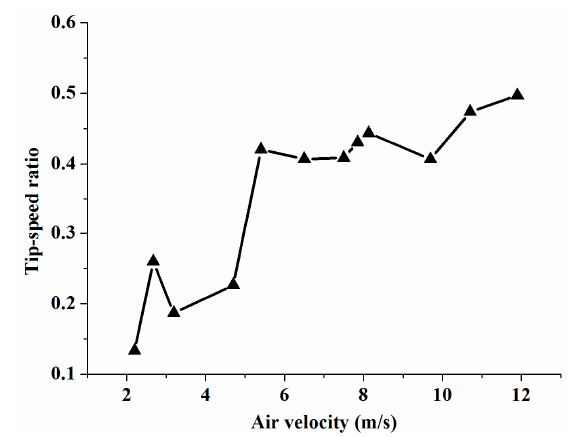
Figure 12. Variation of tip-speed ratio with air